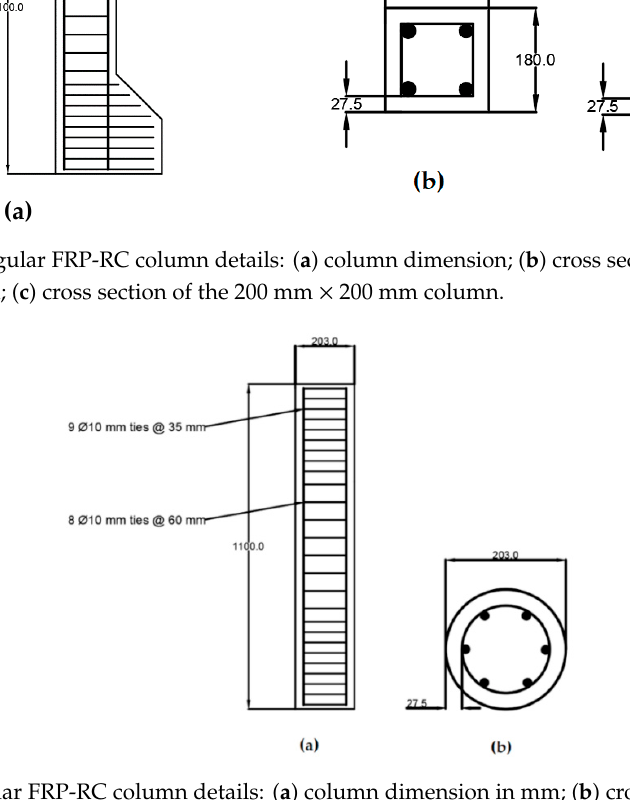
Table 5. List of groups of RC columns considered in the FE parametric analysis.